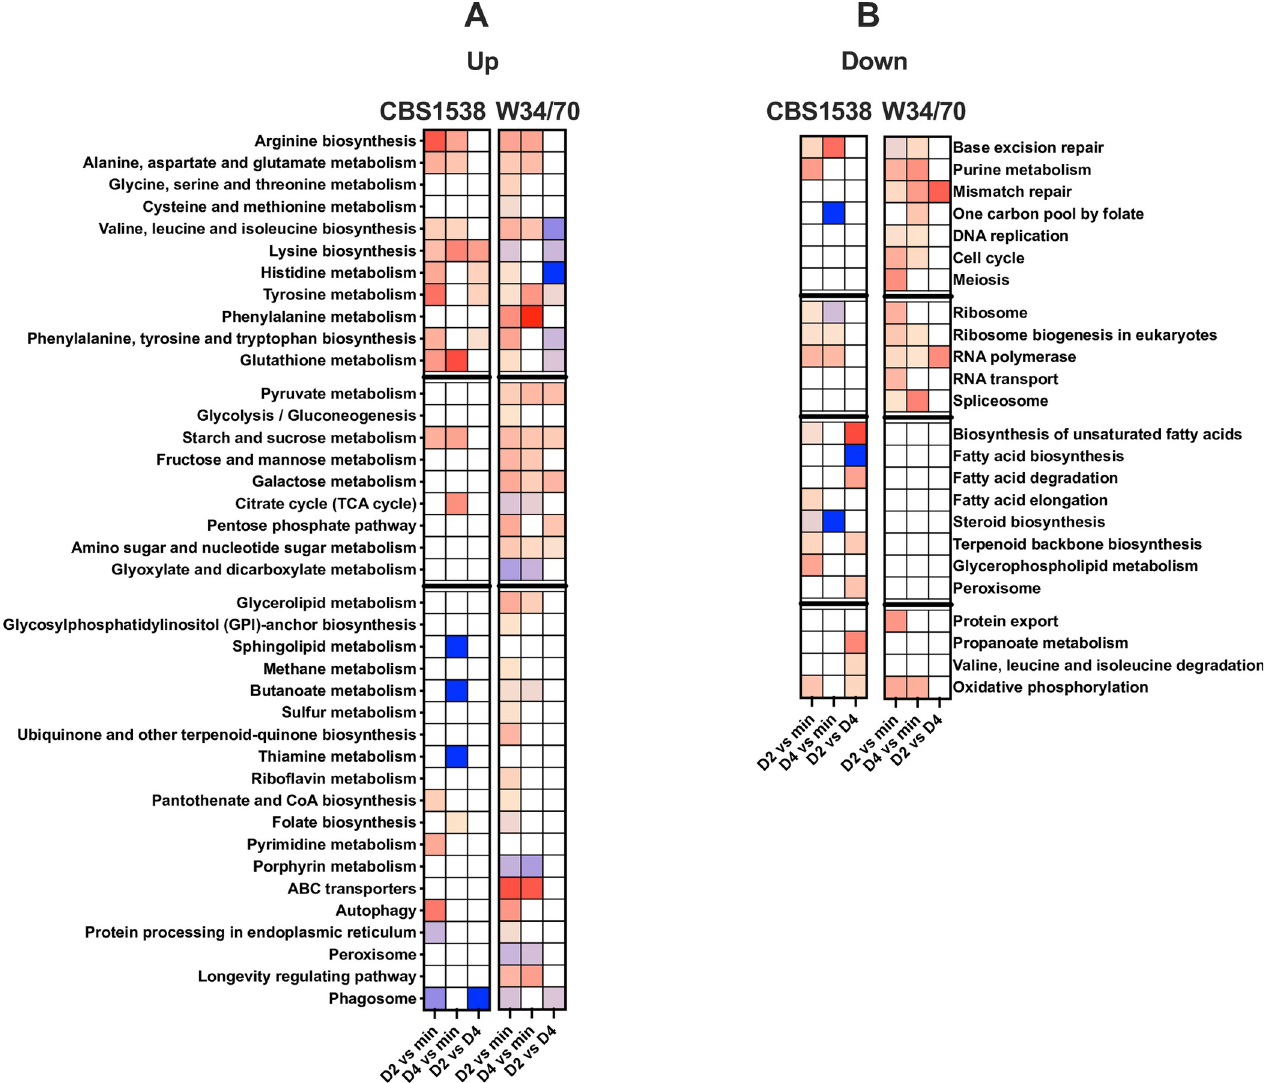
Fig 4. Gene ontology analysis of differentially expressed genes in W34/70 and CBS1538 strains. Genes displaying a log 2 -fold change � 1 (A) or � -1 (B) were examined for enriched gene ontologies using Cluego. The heat map shows deviations from the expected ratio of Sc to Se alleles; expected ratio beige, > expected ratio; beige to red gradient, < expected ratio; beige to blue gradient. Blank cells, no enrichment. CBS1538 expected ratio Sc:Se = 0.24:0.76, W34/70, Sc:Se = 0.55:0.45.